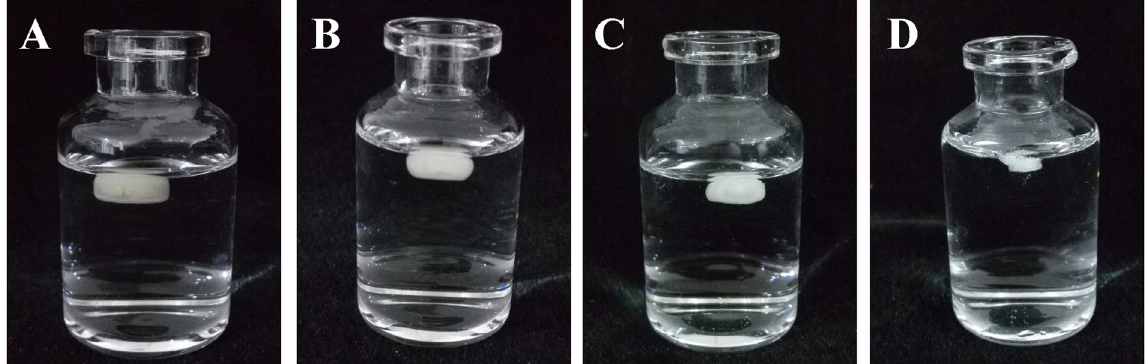
Figure 4. Photographs of DOM-FSR tablets floating in dissolution medium (0.1 N HCl solution) at 37 ± 0.5 °C.